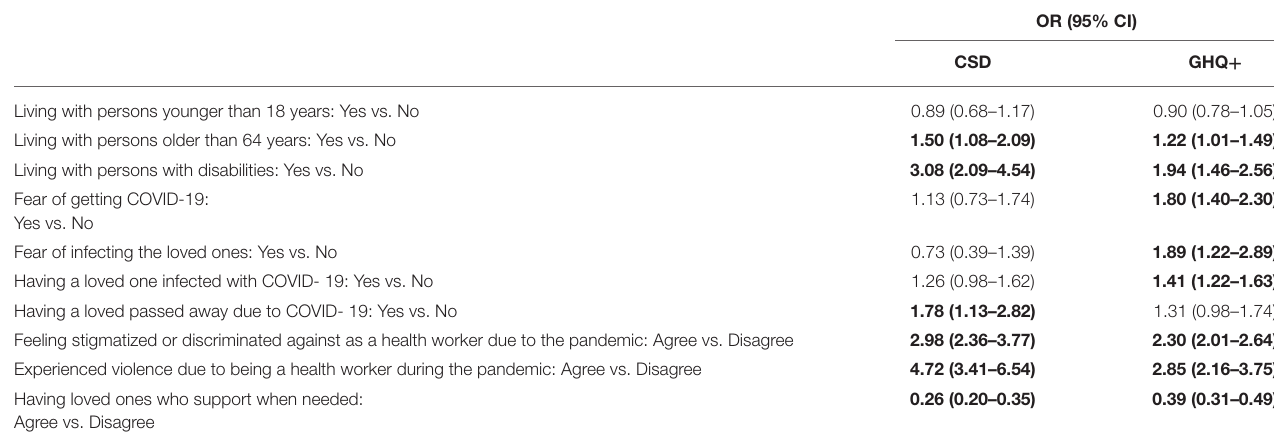
OR (95% CI) CSD GHQ +